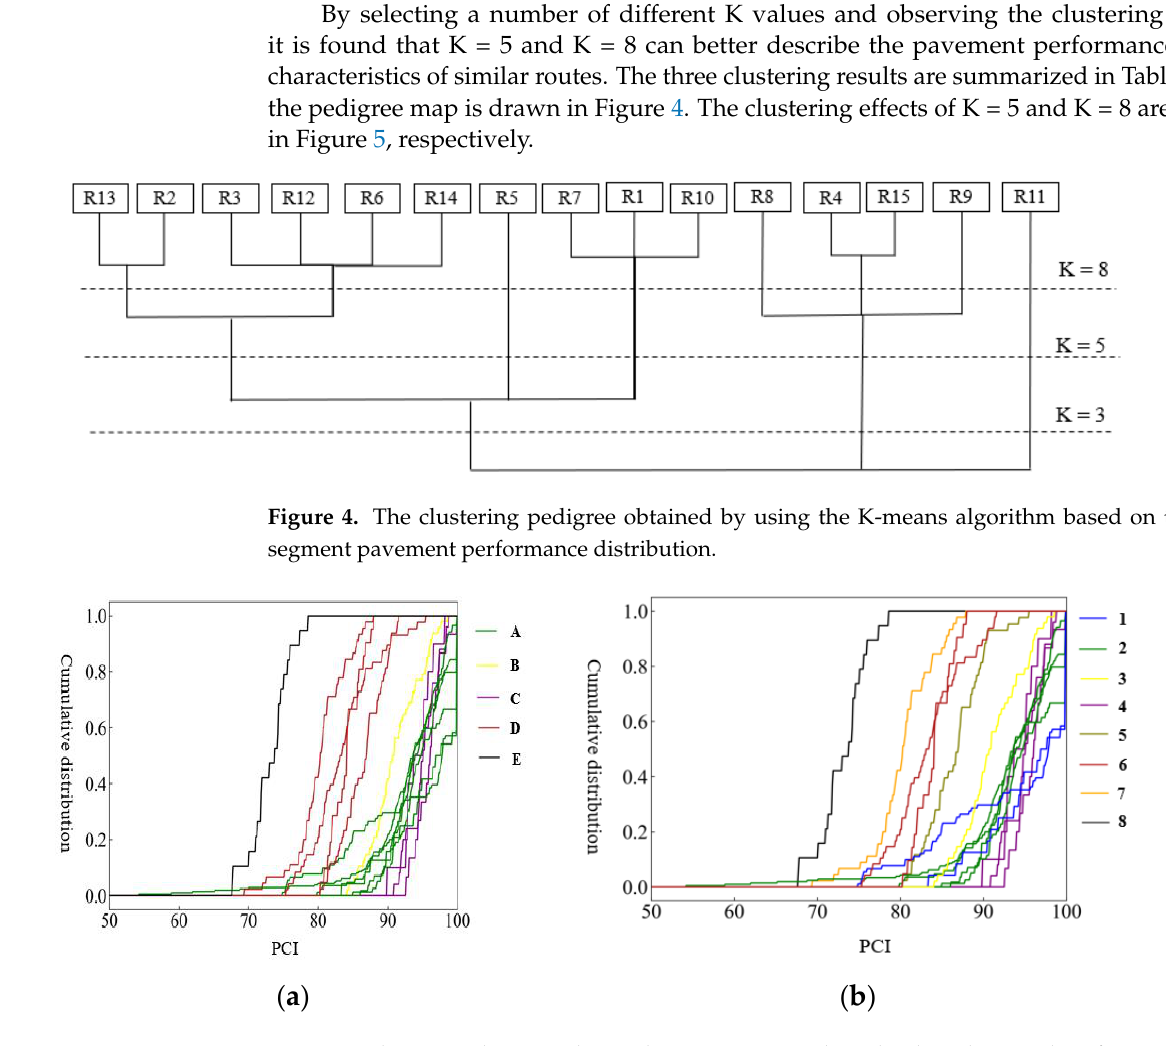
Figure 5. Clustering diagram obtained using K-means algorithm based on road performance distribution of road sections: ( a ) K = 5; ( b ) K = 8.